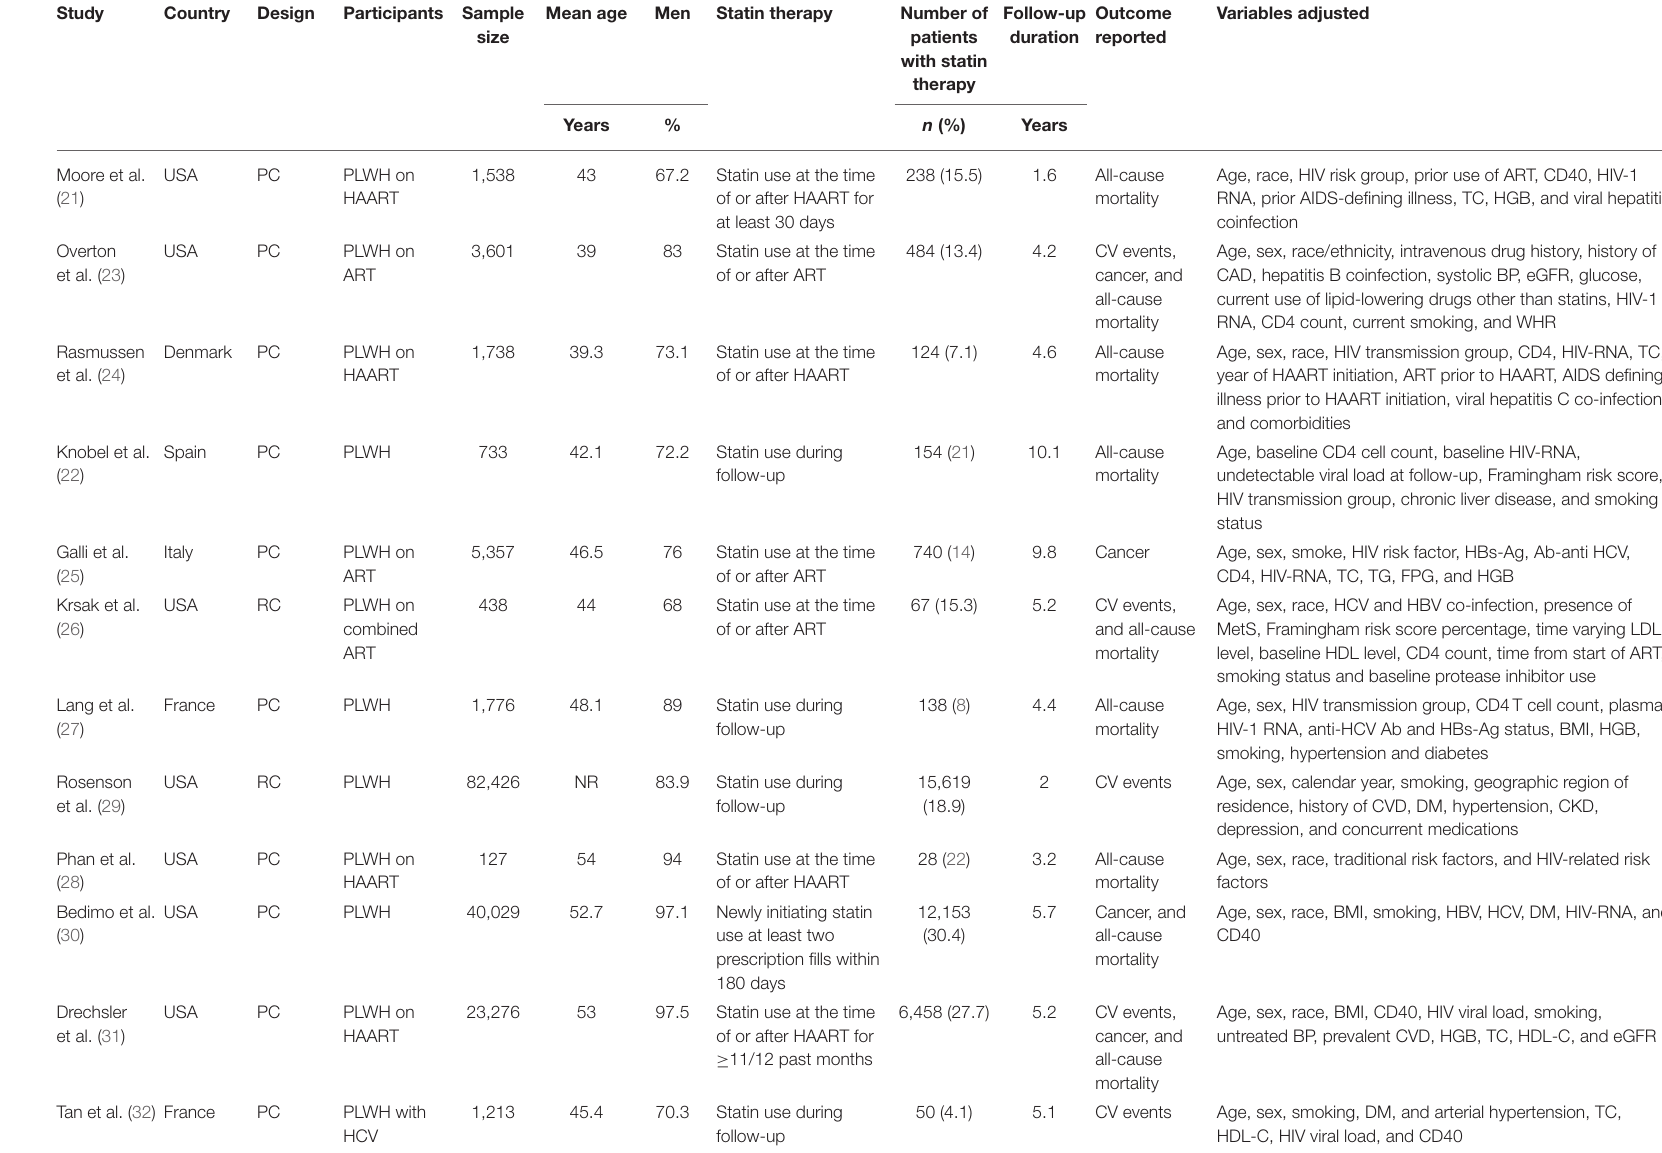
TABLE 1 | Characteristics of the included cohort